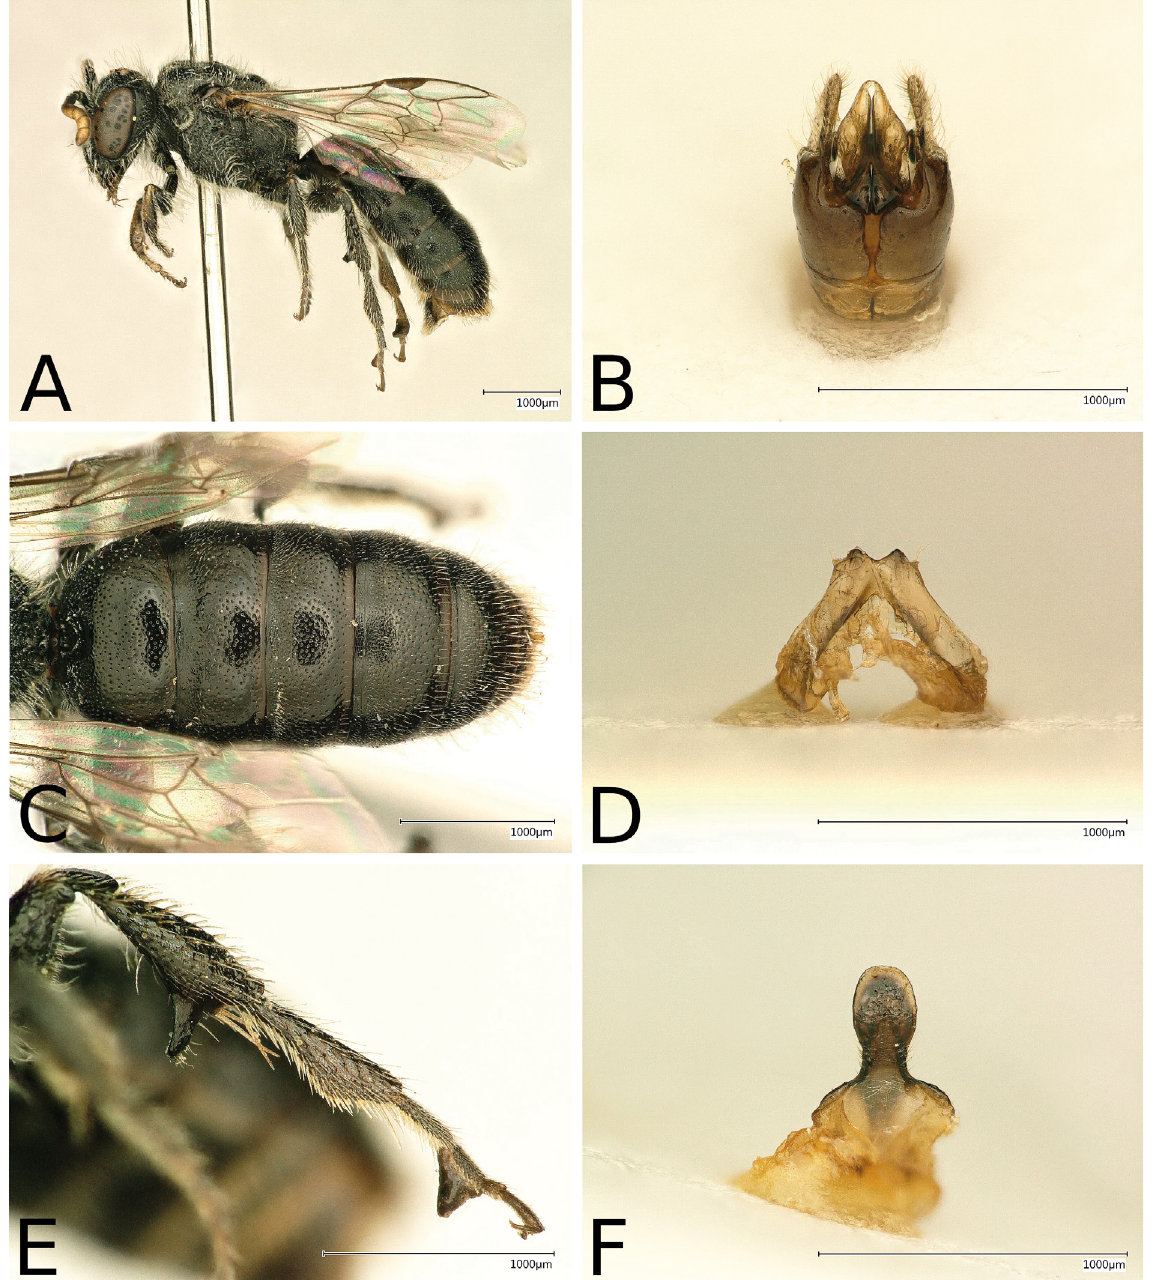
Fig. 10. Scrapter willemstrydomi Kuhlmann sp. nov., ♂, holotype (RCMK). A . Lateral view. B . Genitalia (dorsal view). C . Metasoma (dorsal view). D . S7 (dorsal view). E . Hind leg. F . S8, apical